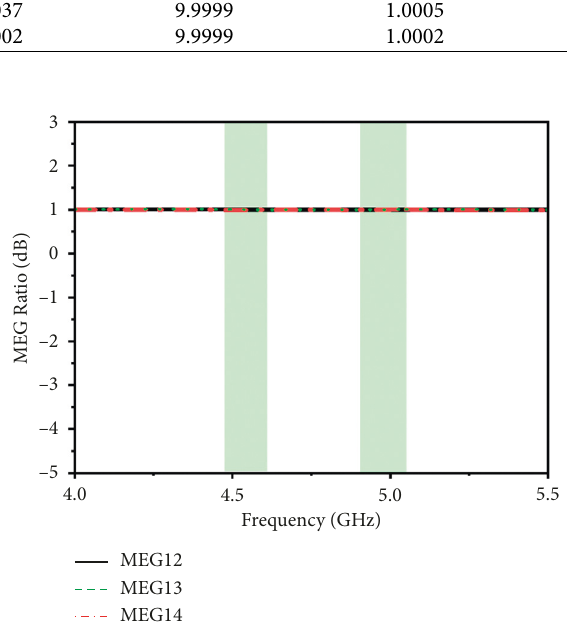
Figure 12: Mean effective gain of MIMO